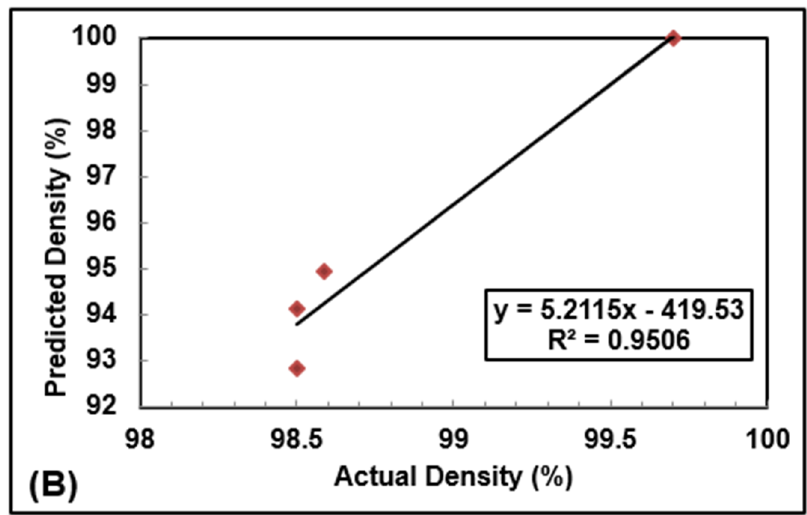
Figure 7. ANN model: ( A ) density prediction actual vs. predicted value and ( B ) statistical correlation between actual vs. predicted value.